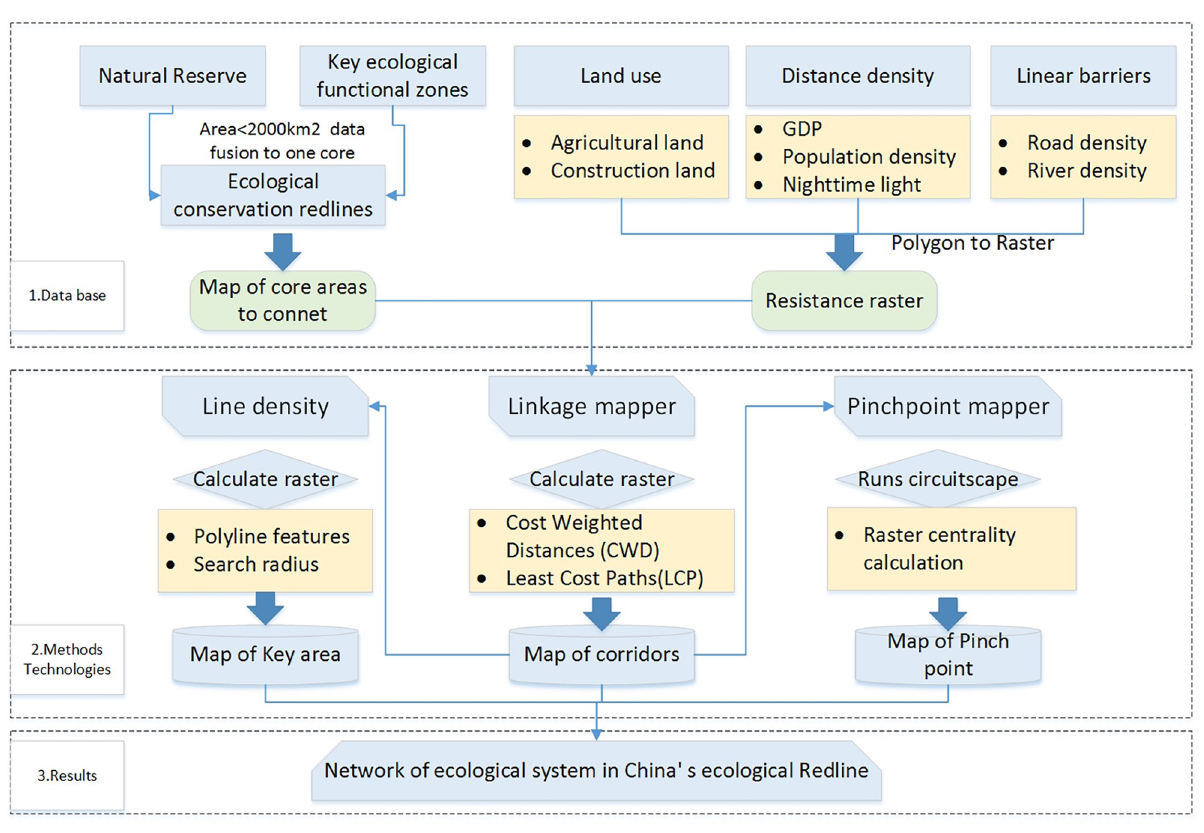
Fig 2. Technical flowchart of the